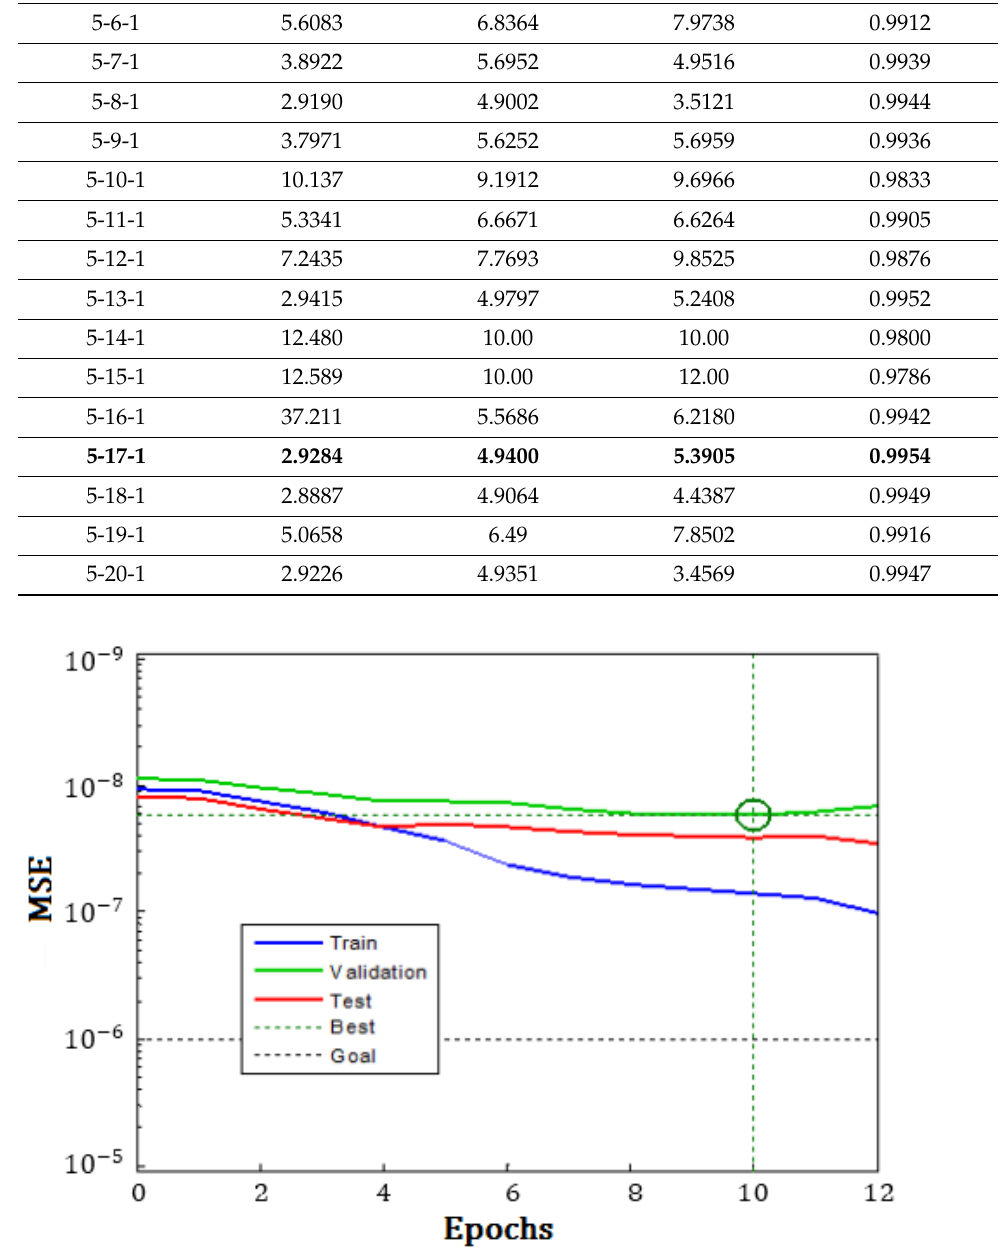
Figure 10. Training of the network (MSE).